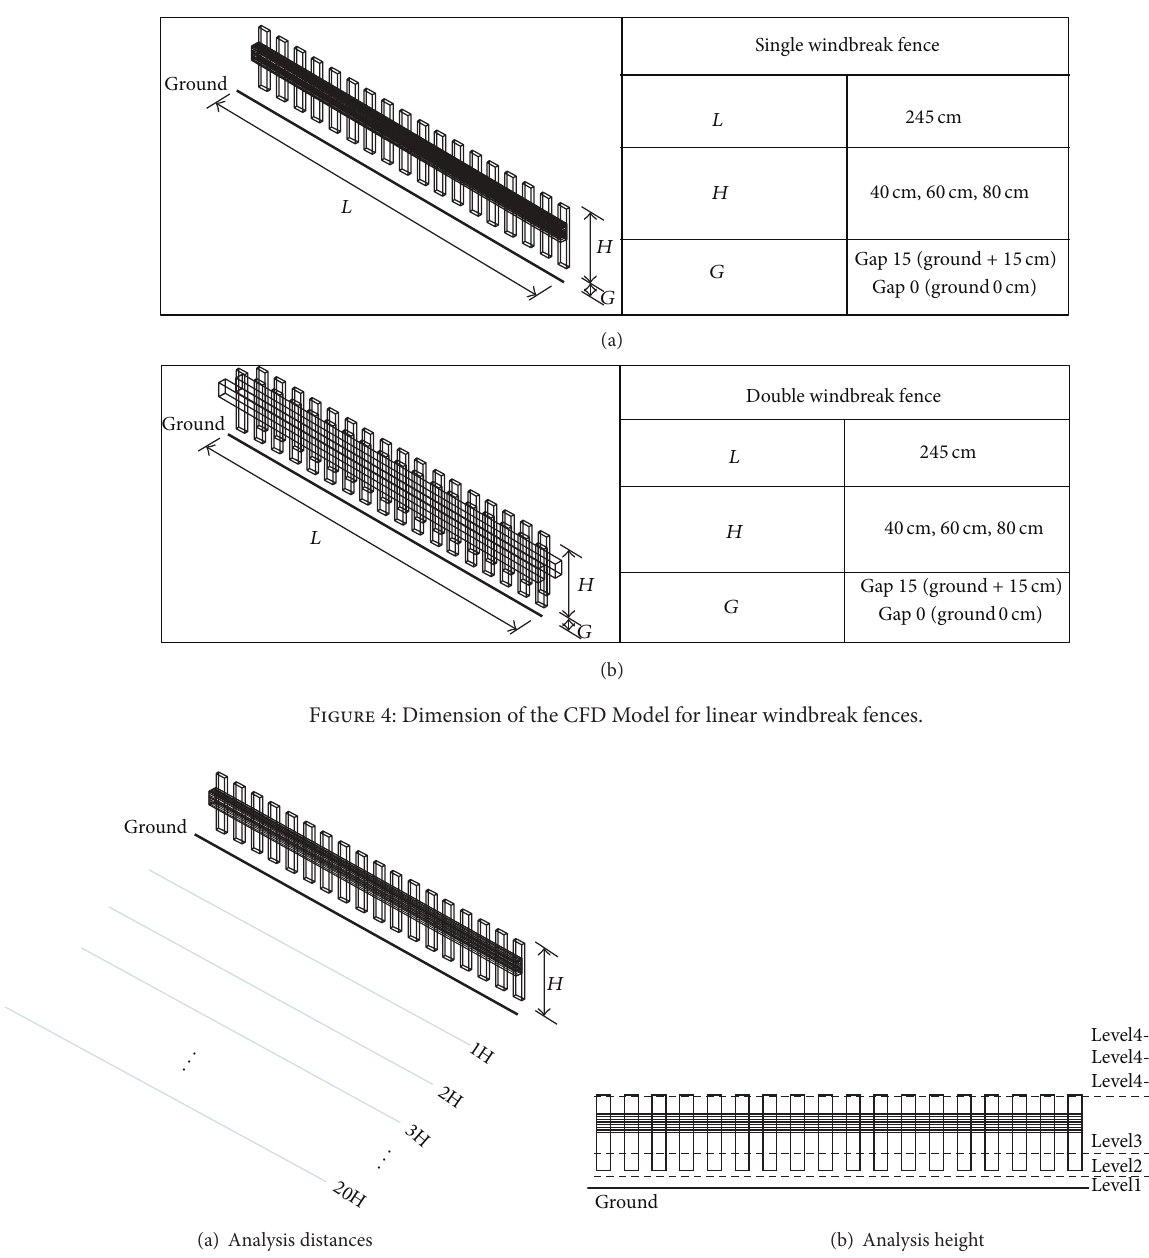
Figure 5: Analysis distances (1H–20H) and heights (LEVEL1–LEVEL4) of the linear windbreak fences.